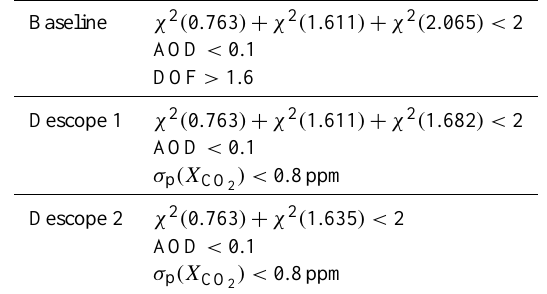
Fig. 7. Signal-to-noise model for GOSAT in the strong CO 2 band. The points correspond to samples along one of the orbits in Fig.